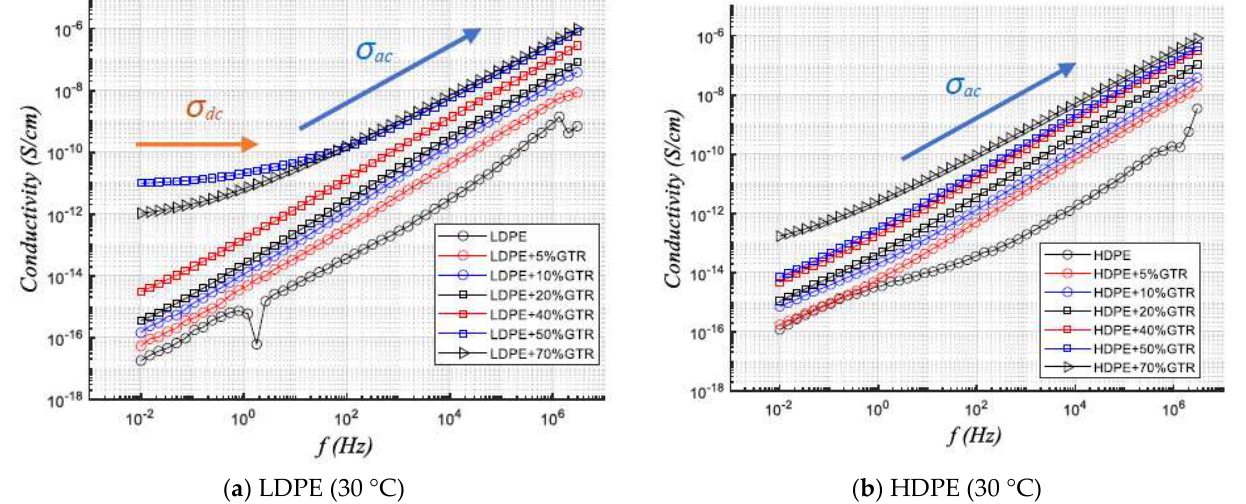
Figure 3. Frequency dependency response of conductivity at 30 °C temperature for ( a ) LDPE/GTR compounds and ( b ) HDPE/GTR compounds.